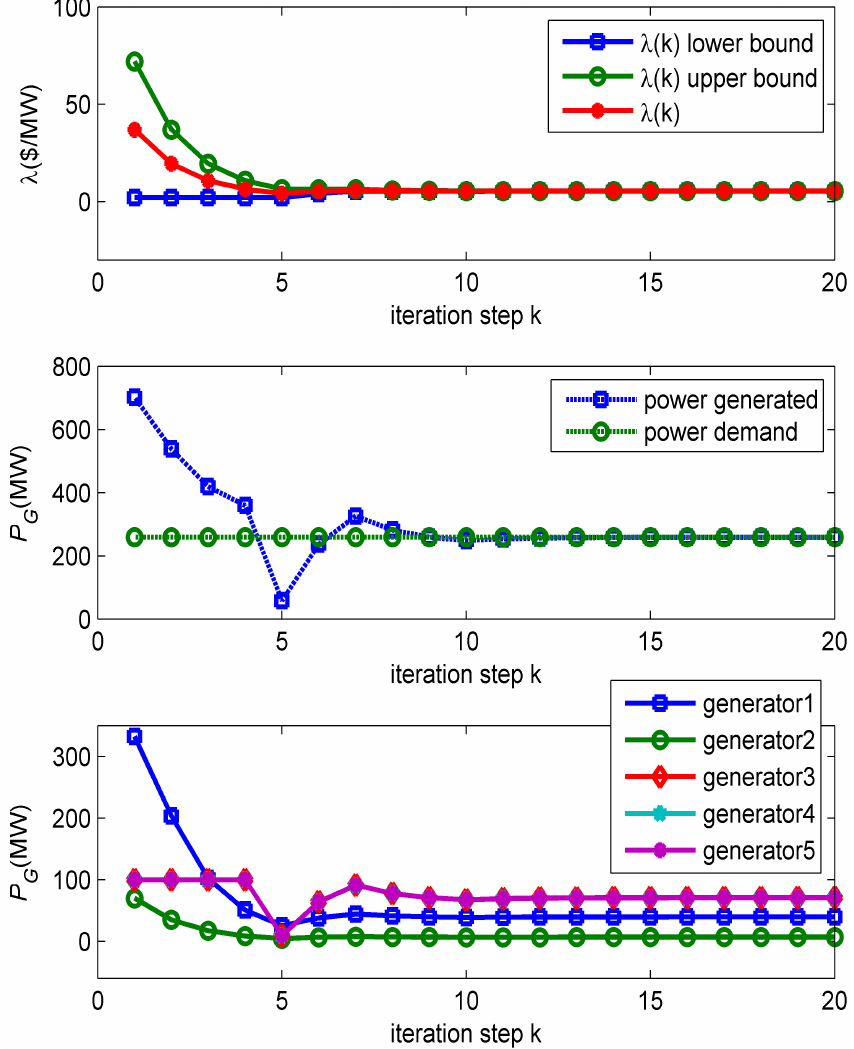
Figure 5. Case 1: with constrains for power generator.